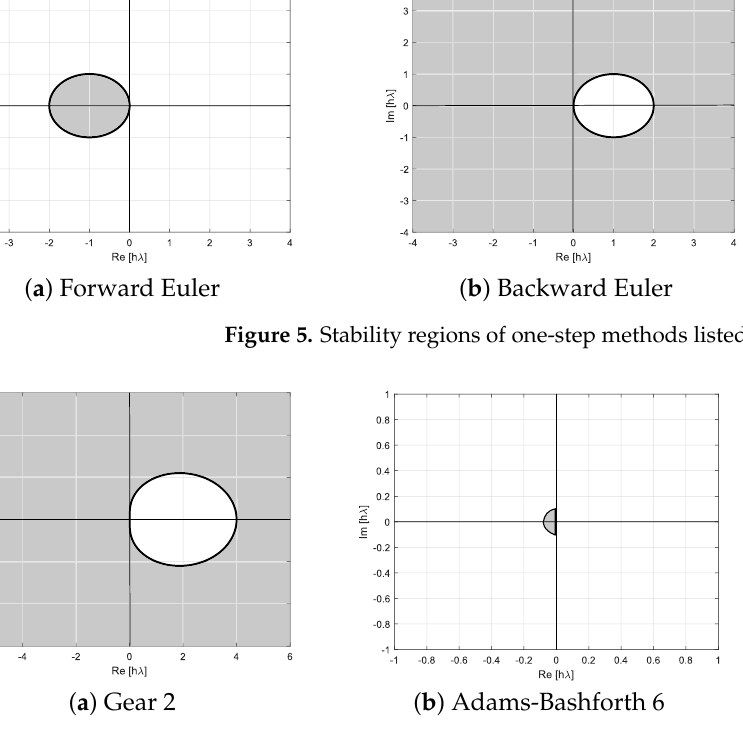
Figure 6. Stability regions of multi-step methods listed in Table